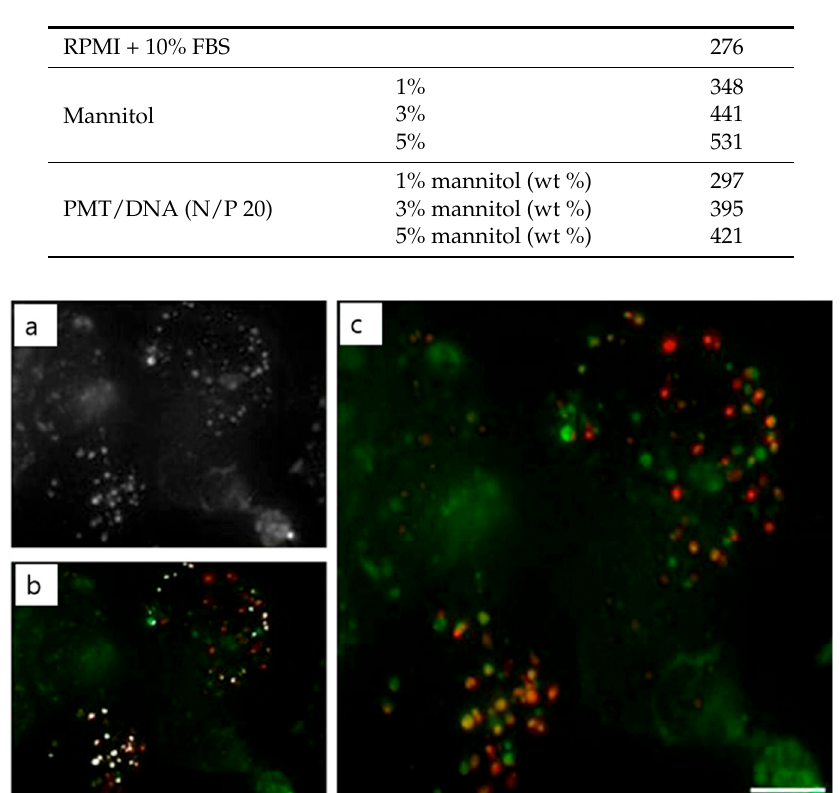
Table 3. Osmolarity (mOsm) of polyplexes Reproduced with permission from [122]. Copyright proceedings from Elsevier.